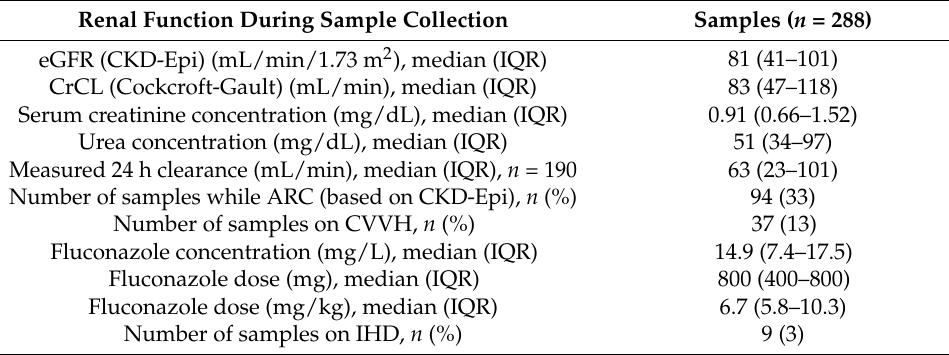
Table 2. Renal function and renal replacement